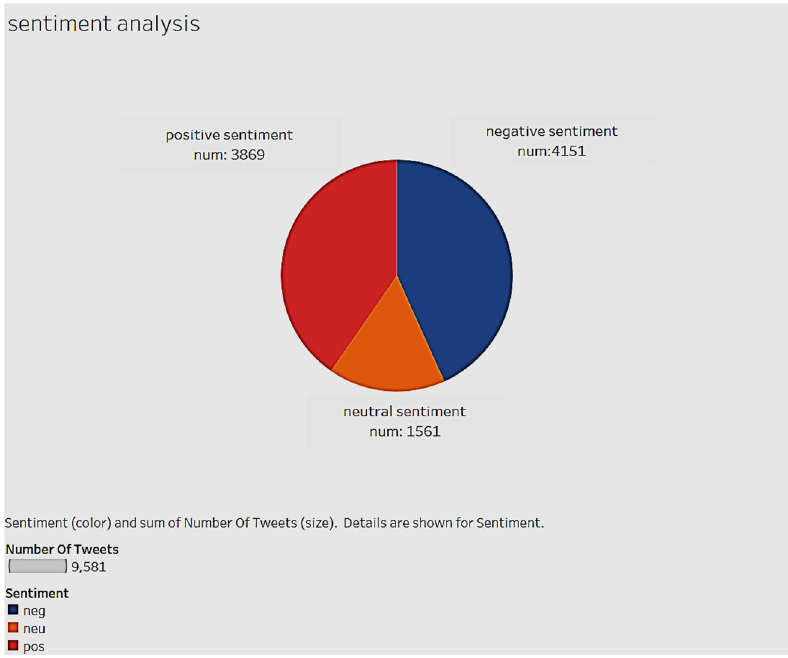
Figure 11. Positive, neutral and negative sentiment tweets in the data set.